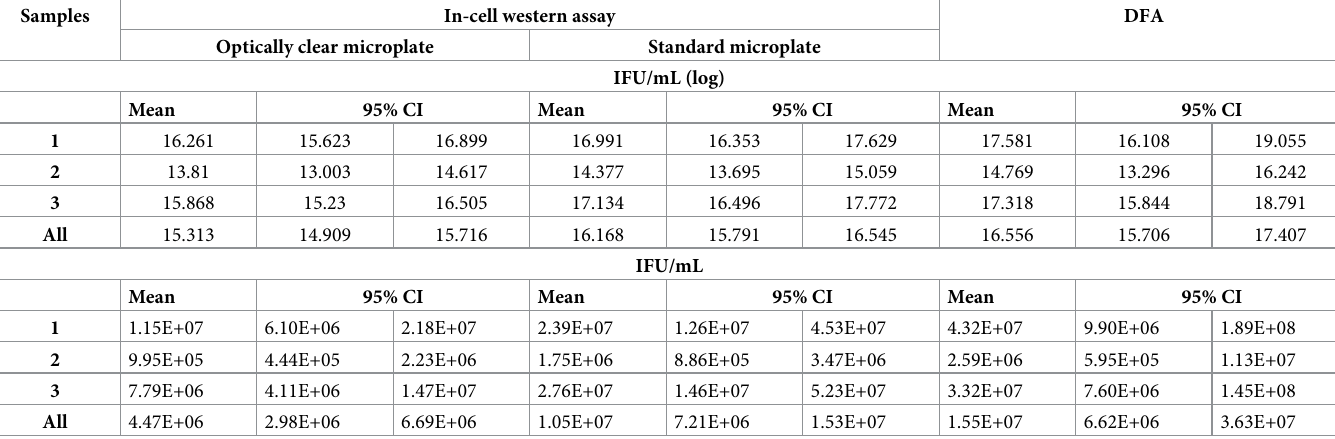
DFA, Direct immunofluorescence Assay; CI, Confidence Interval; IFU, Inclusion Forming Unit.